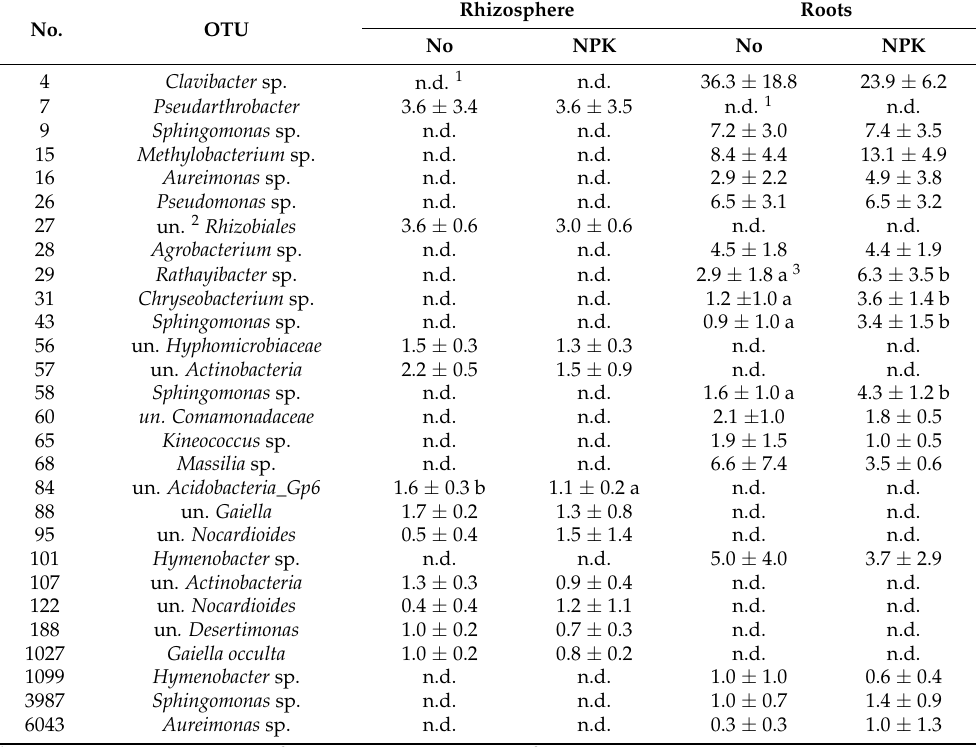
Table 2. The relative abundance (%, mean ± standard deviation) of the dominant bacterial OTUs in the rhizosphere and roots of tomato plants grown under different fertilization on Phaeozem in the open field in the south of West Siberia (An OTU was considered dominant if its relative abundance was ≥ 1.0%).